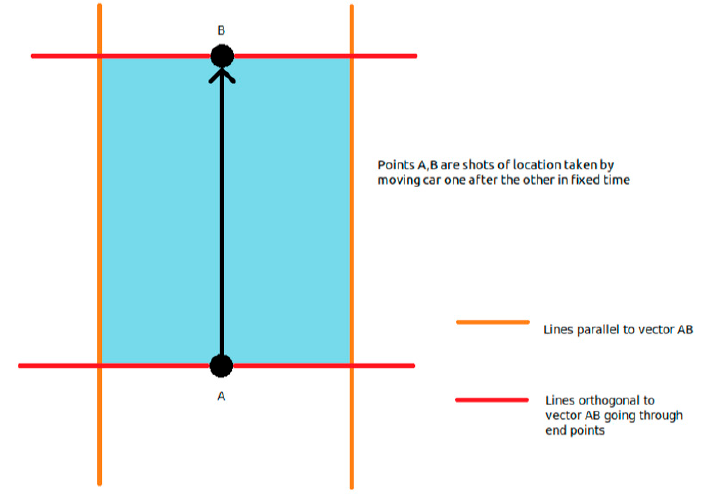
Figure 4. Rectangle generated by the algorithm to calculate the order of vehicles.